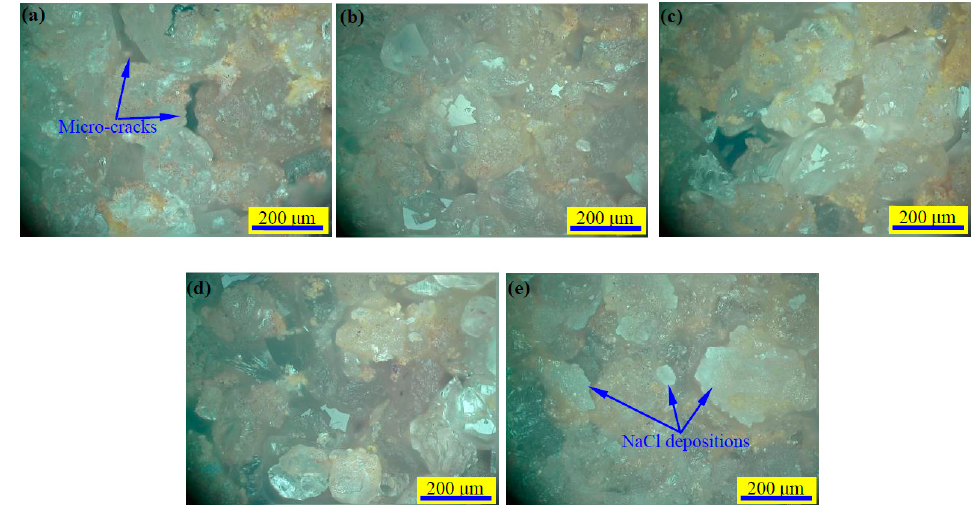
Figure 3. Microstructure of tested sandstone under different solution conditions. ( a ) Dry specimen; ( b ) Distilled water (0% brine); ( c ) 10% brine; ( d ) 20% brine; and ( e ) 30% brine.